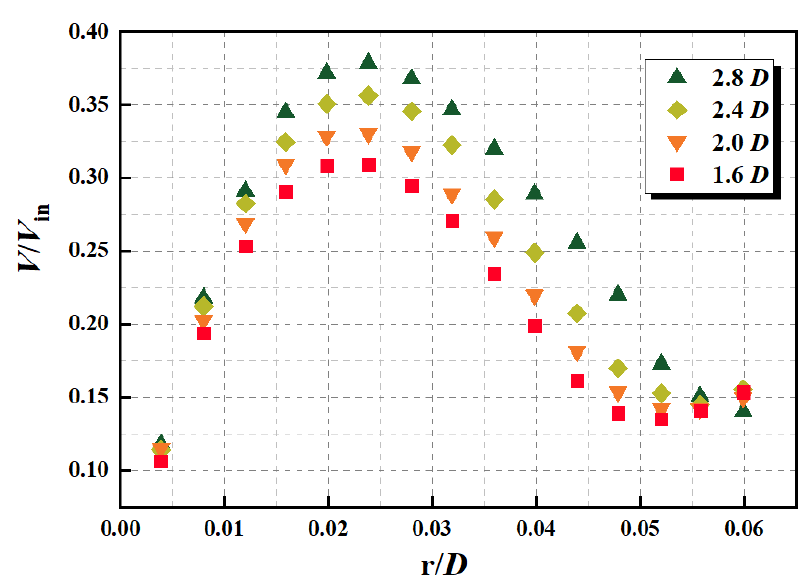
Figure 11. Variation of tangential velocity with radius at different depths .